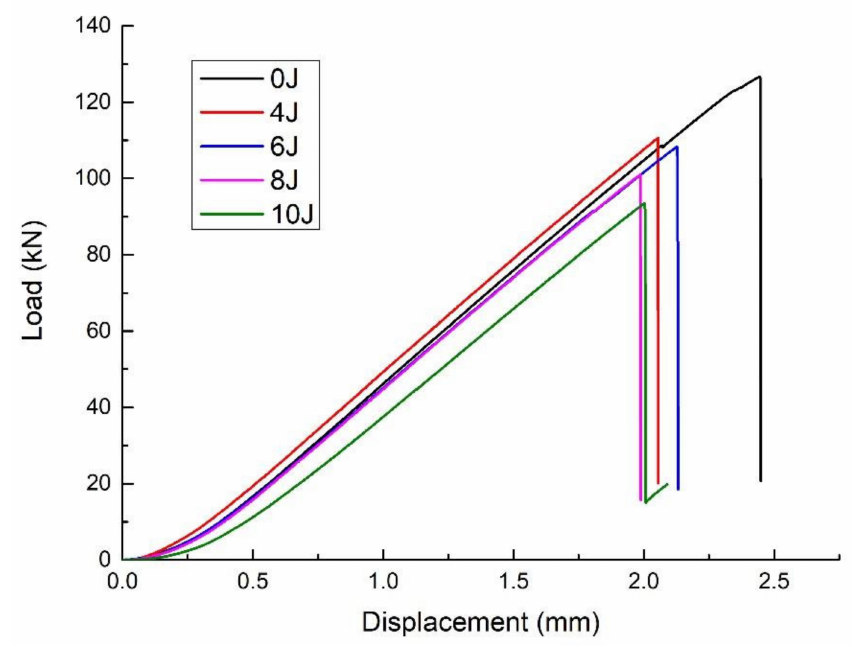
Figure 12. Load versus displacement curves of